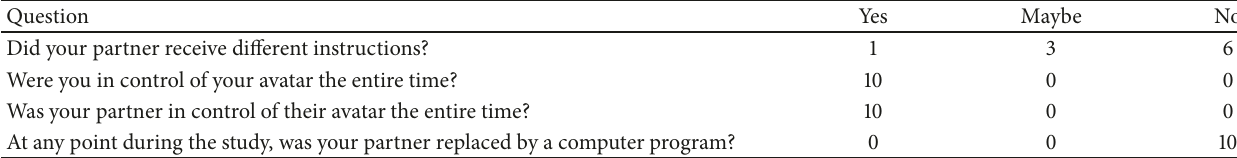
Table 2: Exit Question